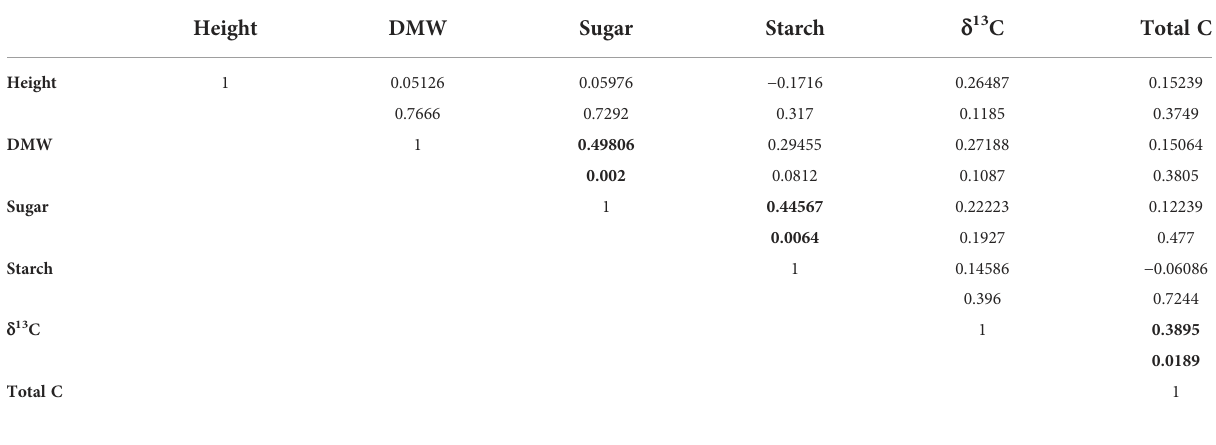
DMW, DM weight; Total C, total C content. Values in bold font indicate signi fi cant correlations in the con fi dence level of p<